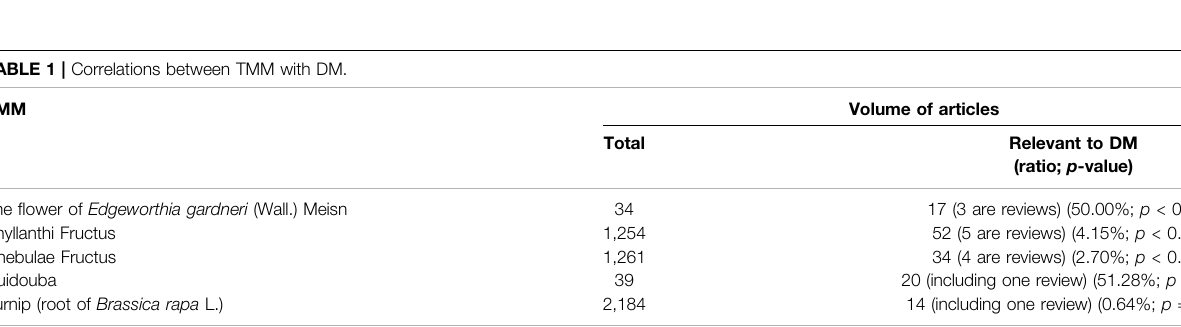
TABLE 1 | Correlations between TMM with DM.